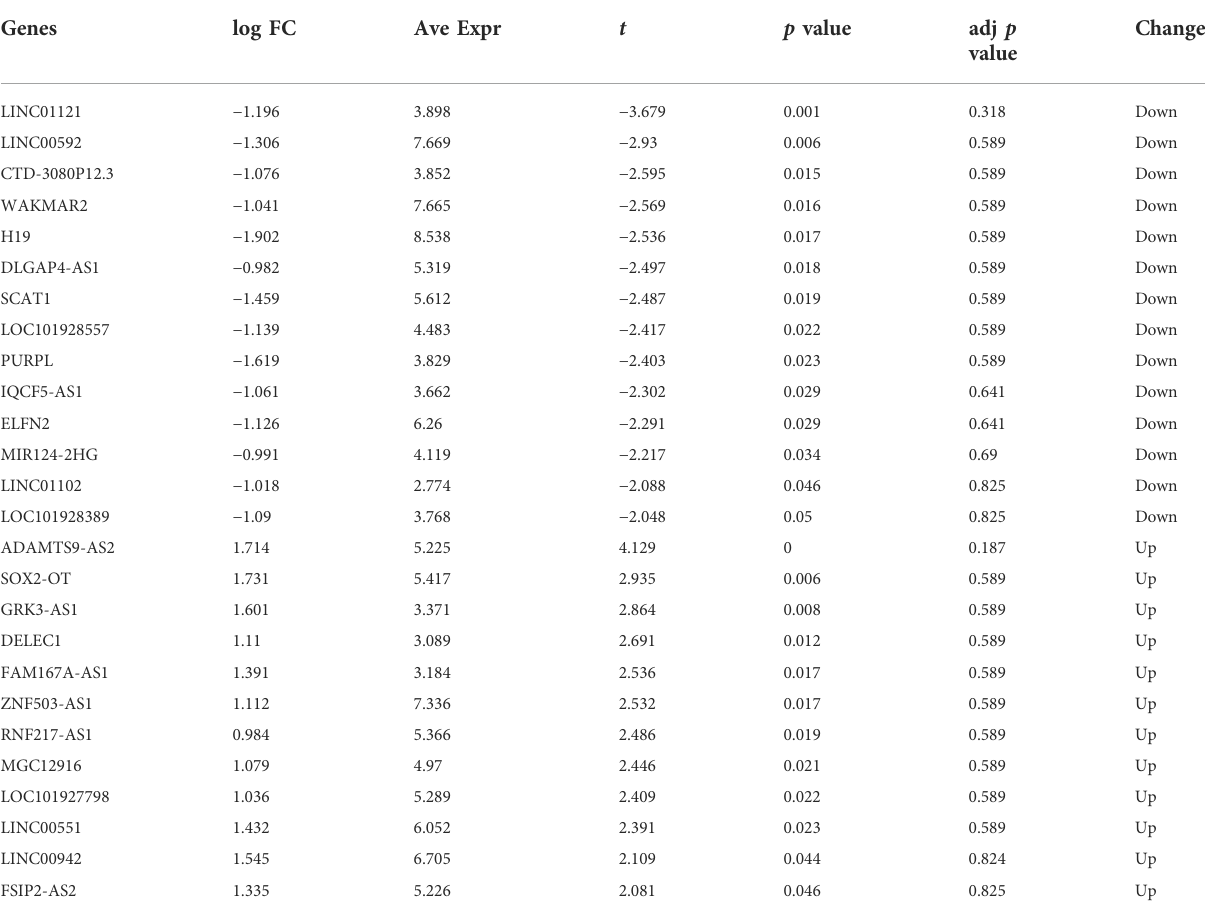
TABLE 1 Differential expression results of immune-related lncRNAs in GSE45670. Genes log